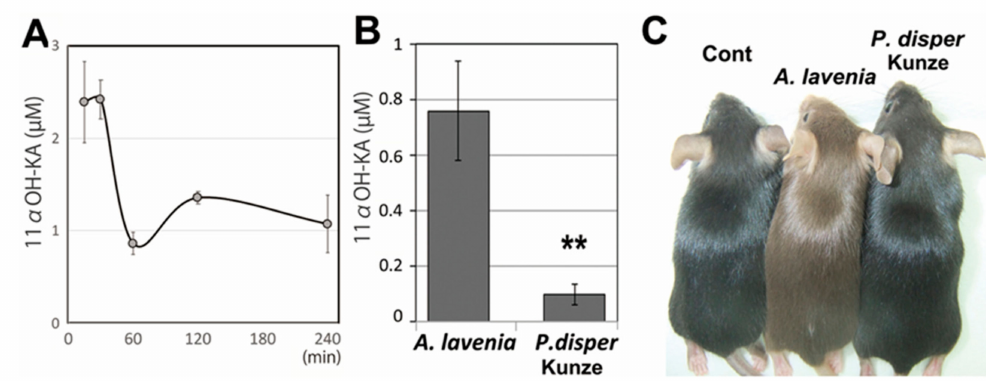
Figure 5. ( A ) Mice were orally administrated 11 α OH-KA (100 mg / kg), and their blood was collected at the indicated time. The 11 α OH-KA contents were measured by LC-MS analyses. The means and SD are indicted ( n = 3). ( B ) Mice were treated with A. lavenia or P. dispar Kunze leaf extracts in drinking water (a twofold dilution of the extract which was prepared by the same methods in Figure 4A) for one week, and blood was collected for 11 α OH-KA measurement ( n = 3). The means and SD are shown. ** indicates p < 0.01. ( C ) Three-week-old mice ( n = 2; see also Supplementary Materials Figure S4) were treated with the water extract (in Figure 5B) for two weeks, and then the pigmentation in the newly grown hair was examined by